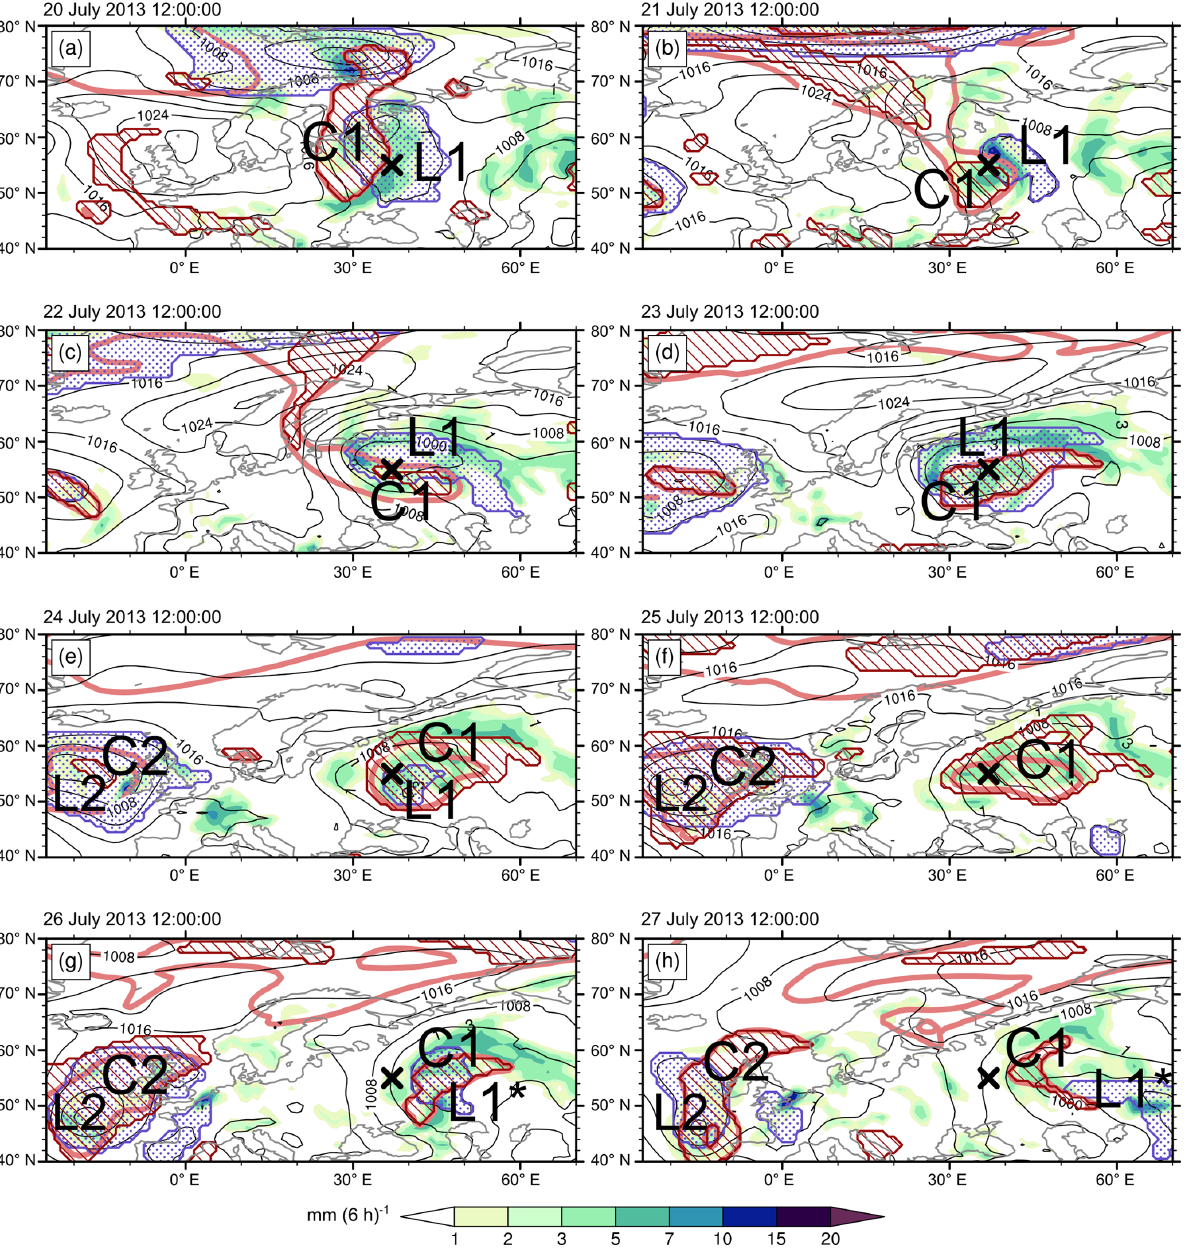
Figure 3. Synoptic evolution of the longest wet spell near Moscow, Russia ( S 1 (55 ◦ N, 37 ◦ E)). Shading depicts total precipitation accumu- lated over the preceding 6h. Light red contours show the 2PVU dynamical tropopause at 320K, while black contours show SLP (contour interval of 4hPa). Cyclones are depicted by blue stippling, and the red hatching depicts the projection of cutoff objects (see “Data and methods” for details), whose outline therefore does not need to be co-located with the 2PVU contour at 320K. The black cross in all panels marks the grid point at 55 ◦ N, 37 ◦ E. Labels help to identify the features discussed in the main text. Panels are shown daily at 12:00UTC from 20 to 27 July